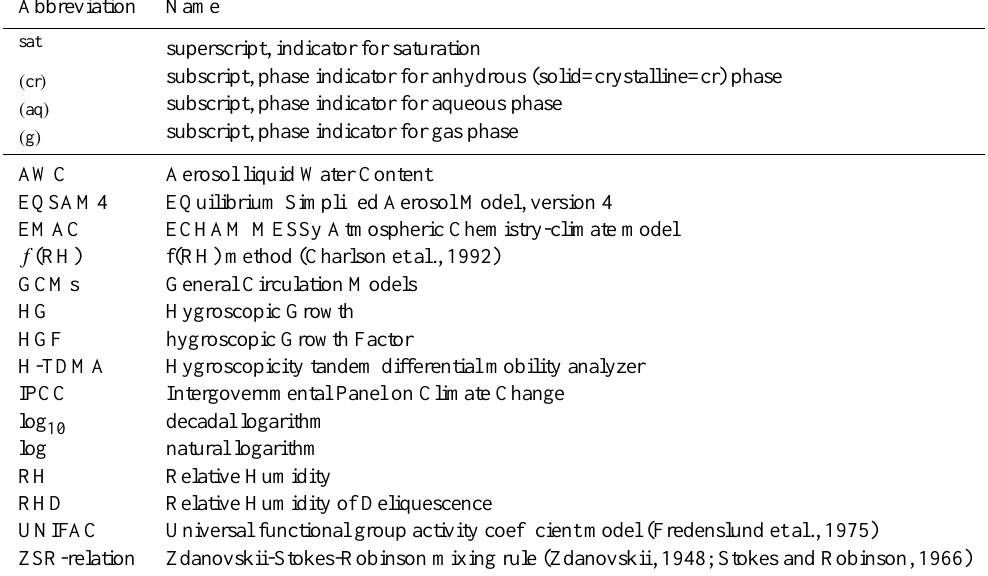
Table A3. List of names and